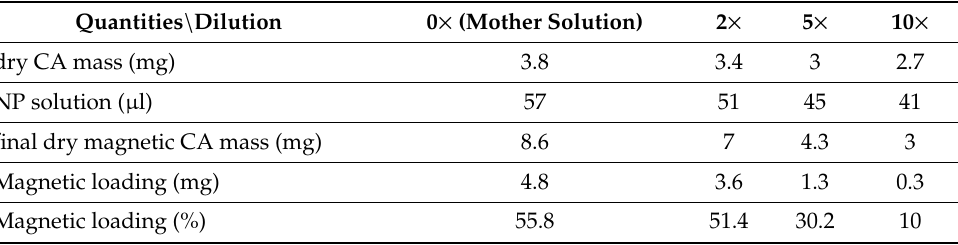
Table 1. Details of materials’ quantities used in the preparation of the inner magnetic CA fibrous layers for di ff erent magnetic iron oxide nanoparticles (MIONP)-OA. Oleic Acid (OA) solution concentrations. (2 × , 5 × , and 10 × denotes the times of dilution of the mother 0 × solution with deionized water). Mother solution 0 × concentration: 1.0703 g / cm 3